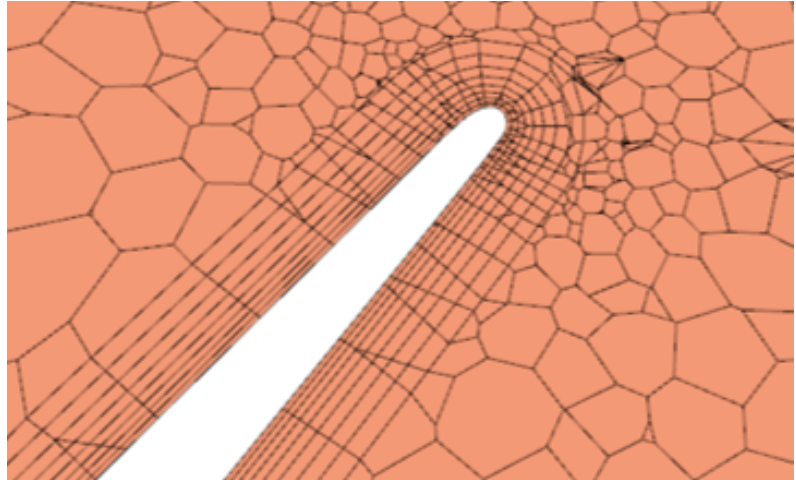
Figure 5. Mesh details at the leading edge of the rotor (reference mesh of 75M